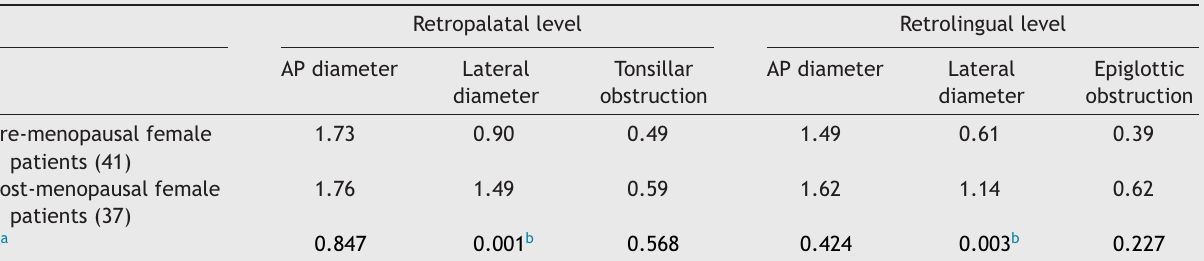
Comparison of DISE score between pre-menopausal and post-menopausal female